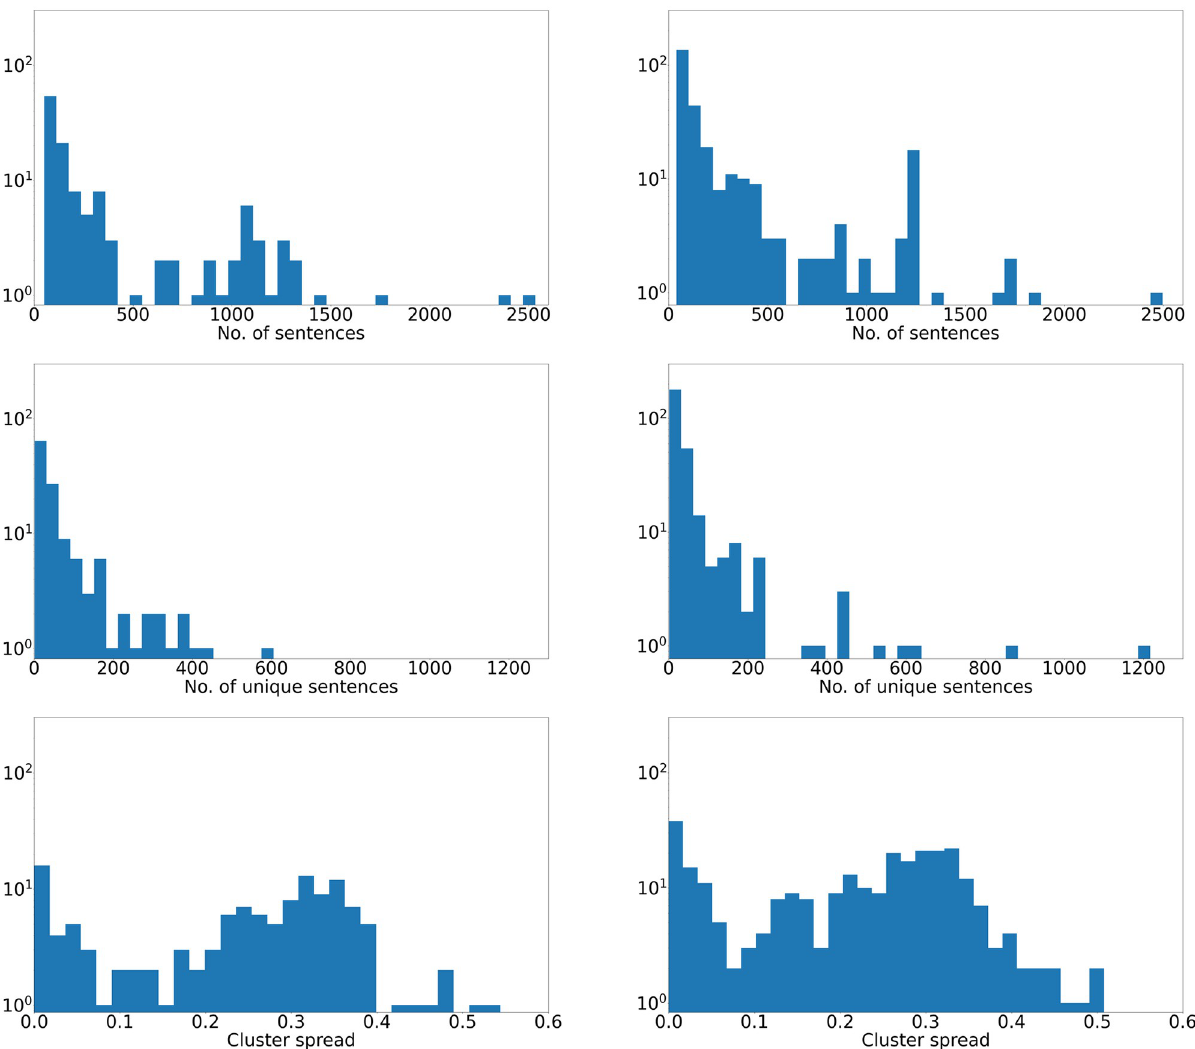
Fig 4. Cluster characteristics for PL (left) and SmPC documents (right). Distribution of total cluster size (top) and number of unique sentences (middle). Cluster spread histogram (bottom) shows mean Euclidean distance from cluster centroid, and suggests separation into different cluster types with regards to